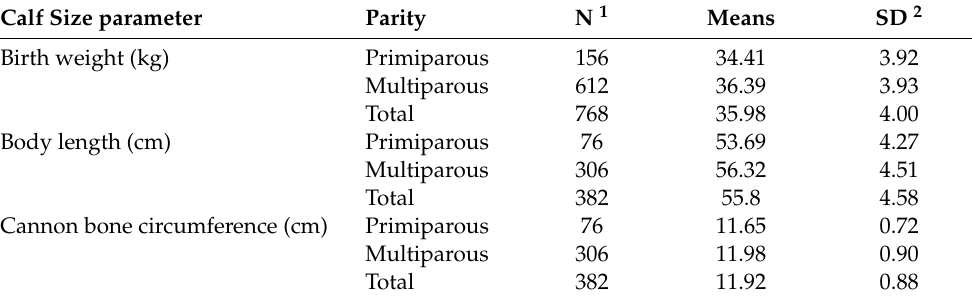
Table 4. Means and standard deviations of calf size parameters in relation to parity of the dam. Calf Size parameter Birth weight (kg)